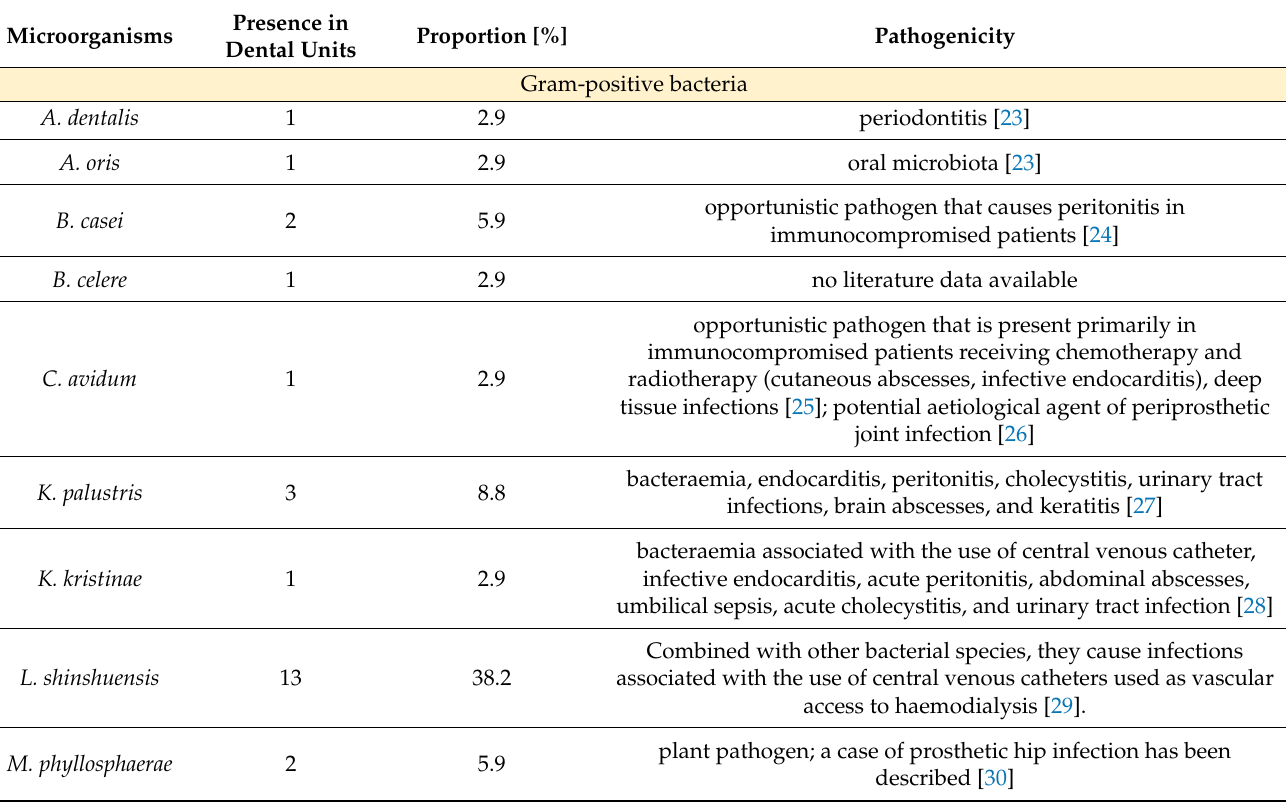
Figure 2. Mould fungi isolated from 5 dental units used for conservative dentistry. Table 1. Microorganisms isolated from water samples and their potential